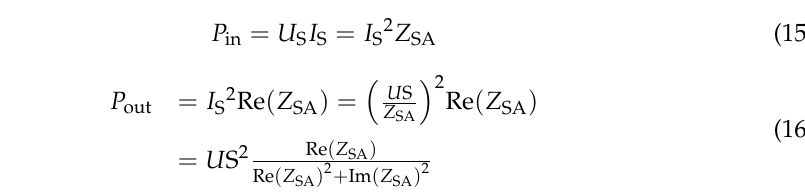
Figure 8. Flow chart of output power interoperability evaluation of electric vehicle WPT system. 4. System Interoperability Simulation In order to verify the correctness of the above interoperability evaluation methods, the simulation modeling of 7.7 kW (WPT2) high power is carried out according to the analysis of the previous evaluation method, and the simulation verification of the